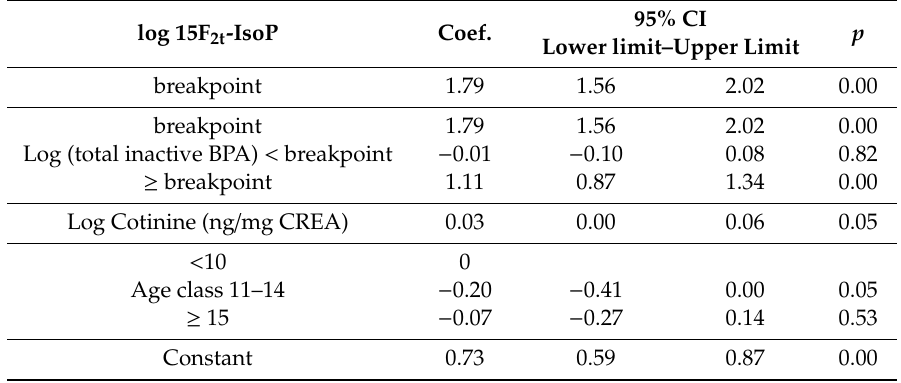
Table 3. Pricewise multiple non-linear regression parameters, with means and 95% confidence interval (CI), of log 15F 2t -IsoP as the dependent variable and log (total inactive BPA), log cotinine, and age as